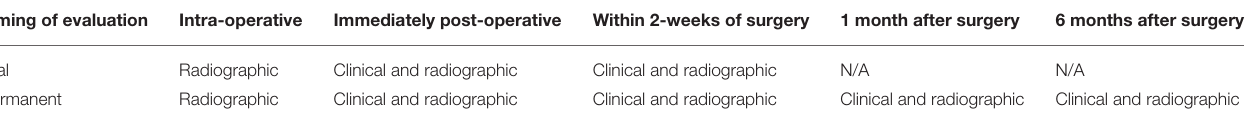
TABLE 1 | Time-course of clinical and radiographic